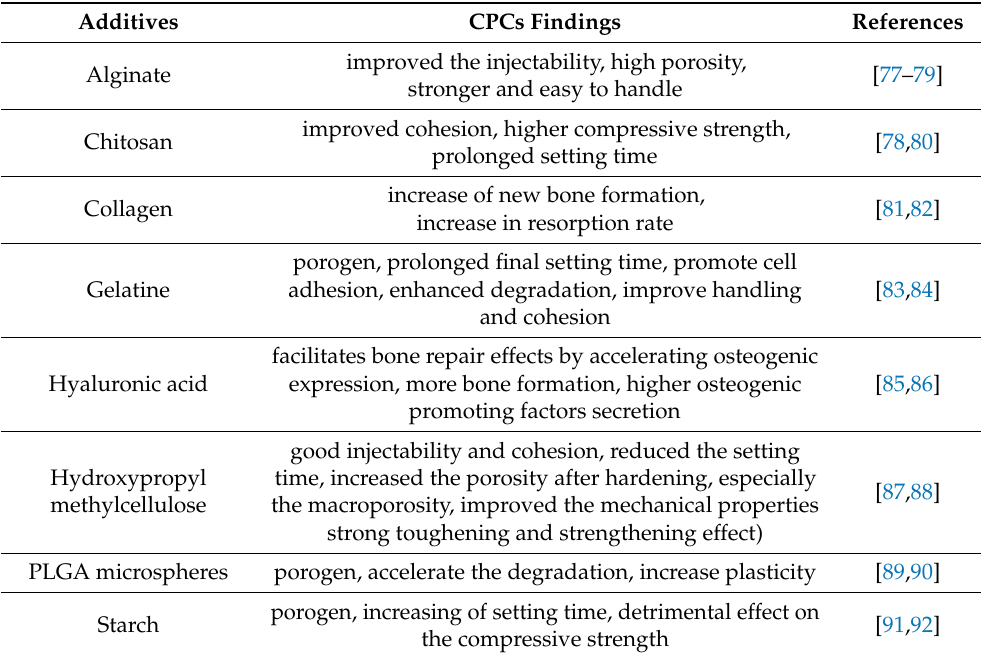
Table 5. Example of polymeric additives for alternative formulations of